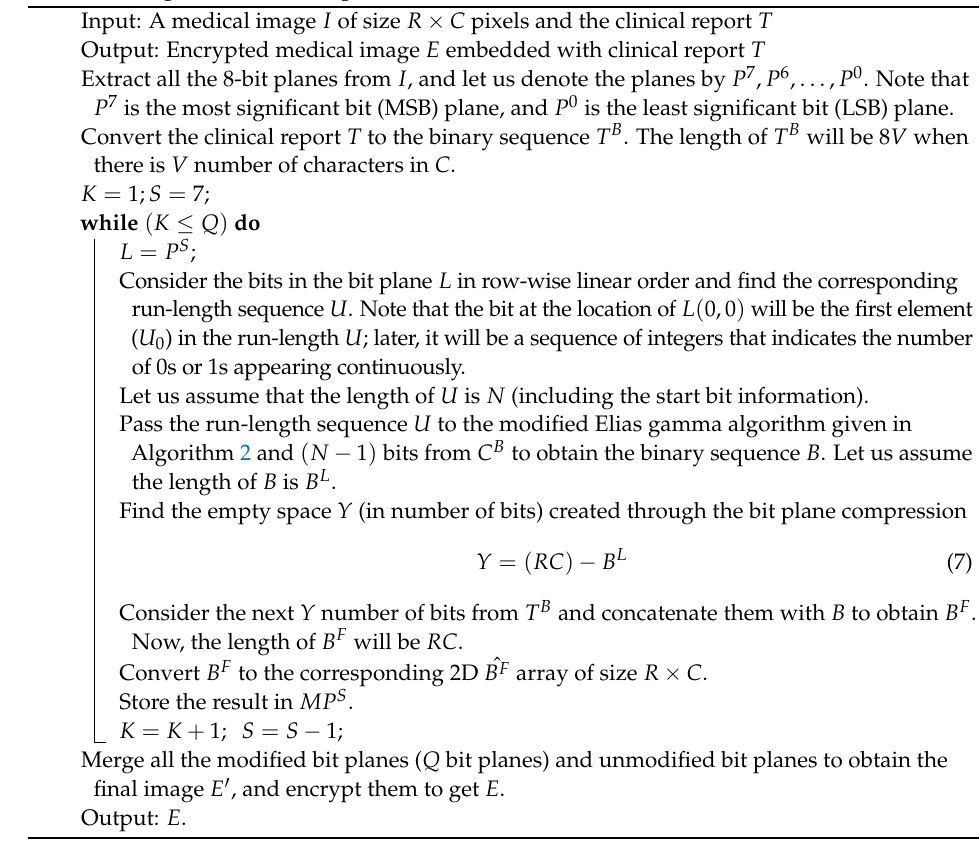
Algorithm 1: Proposed bit plane compression-based RDH scheme using modi- fied Elias gamma encoding